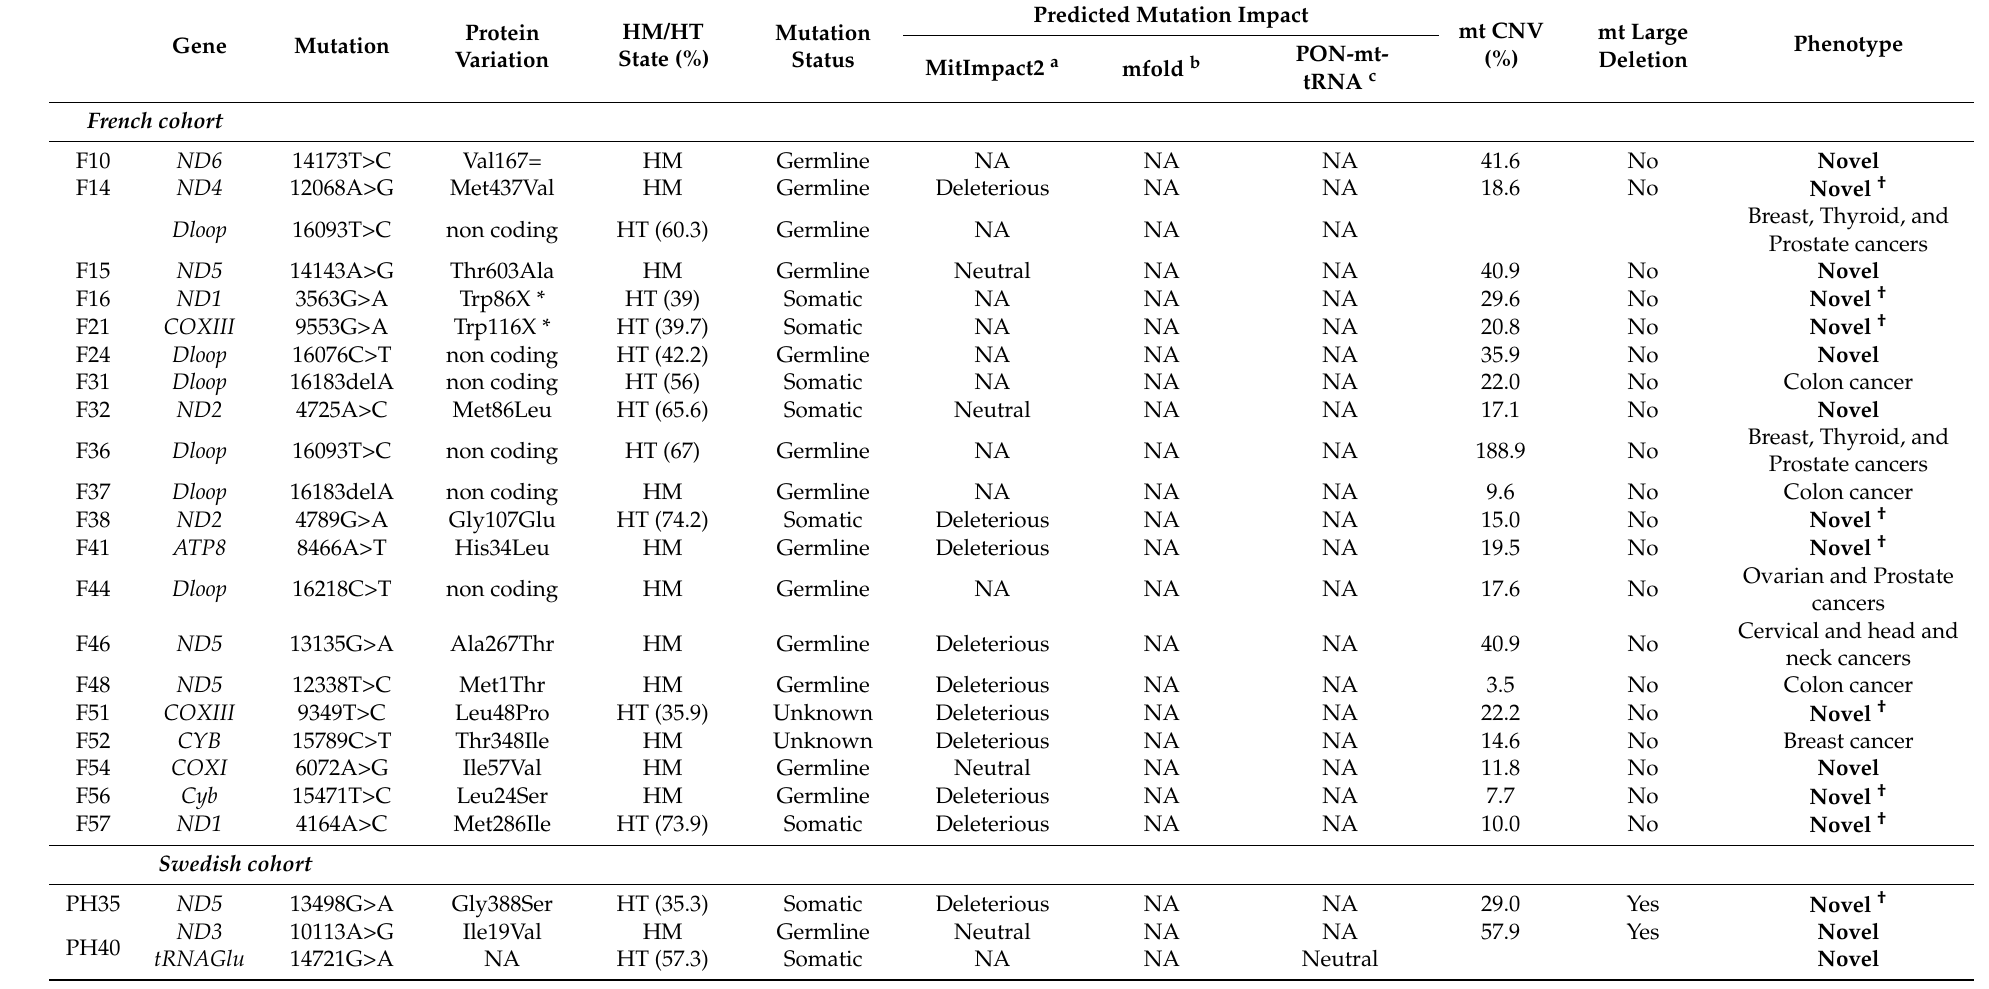
Table 2. Summary of the novel mitochondrial variants and known pathogenic mitochondrial mutations associated with cancer and other mitochondrial alterations detected in PCCs/PGLs from the Swedish and the French